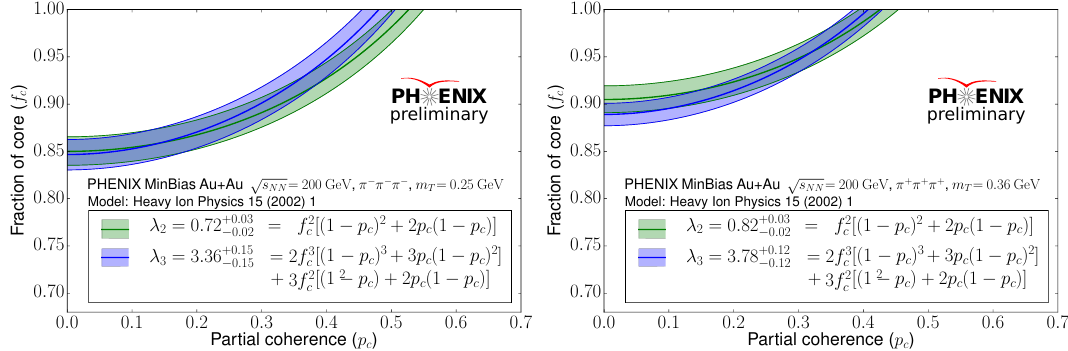
Figure 4. The fraction of the core f c parameter as a function of coherence parameter p c for two different m T